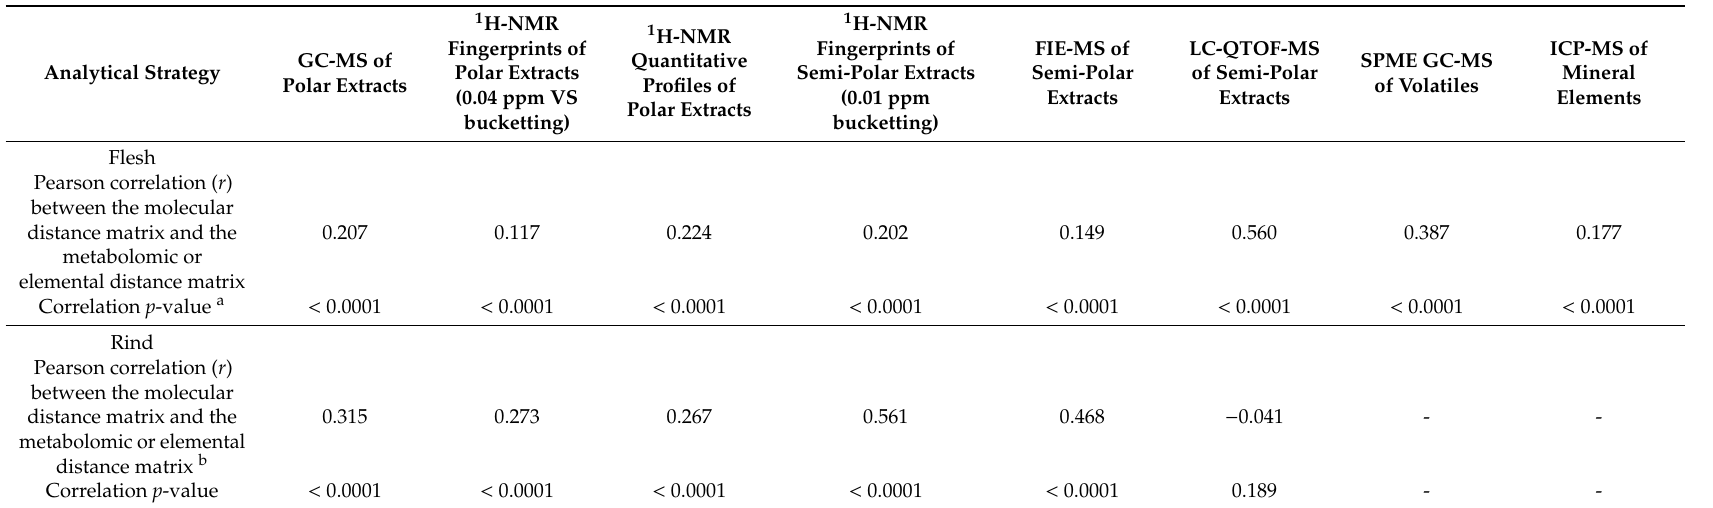
Table 3. Link between genetic and compositional distances measured from melon fruit flesh or rind. Mantel test between the molecular distance matrix and each metabolomic or elemental distance matrix for the 44 accessions genotyped and phenotyped. ‘-‘ indicates that these analyses were not performed on the rind